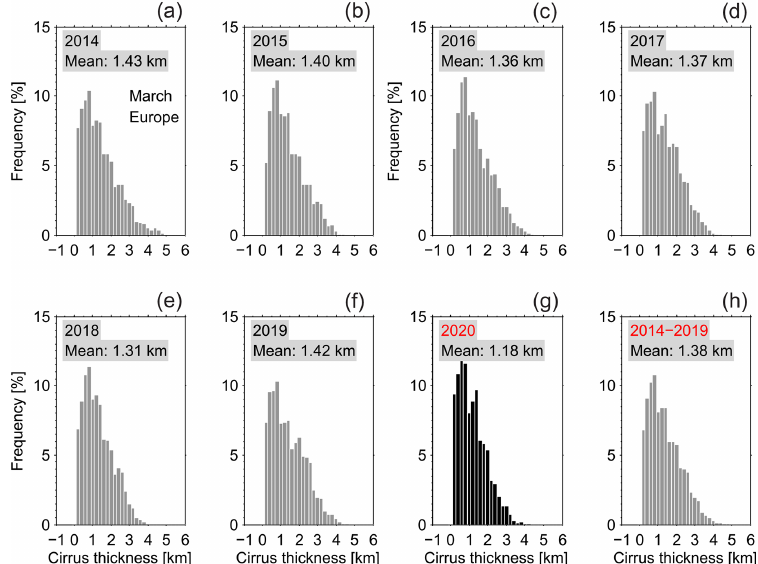
Figure 4. Histograms of the geometrical thicknesses of cirrus clouds detected in March in 2020 (shown in panel g ) compared with the results in the previous years 2014–2019. The composite results of 6 years 2014–2019 are shown in panel (h) . The average cloud thicknesses for each case are indicated in the corresponding panels.